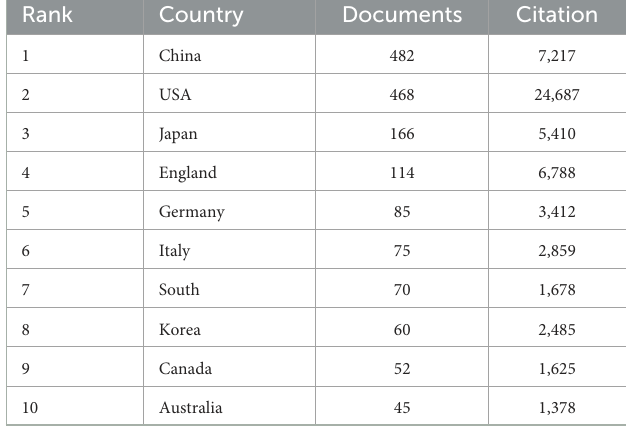
TABLE 3 The top 10 highest cited articles.